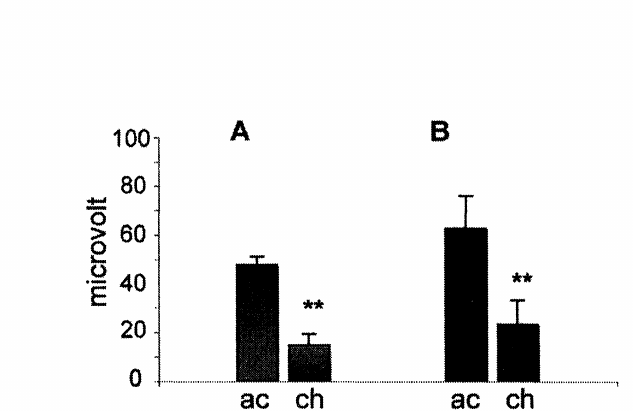
Fig. 5: Difference of b2 peak amplitude between chronic (eh) and acute (ac) implants after treatment with (A) urethane and (B) urethane + scopolamine. ** indicates